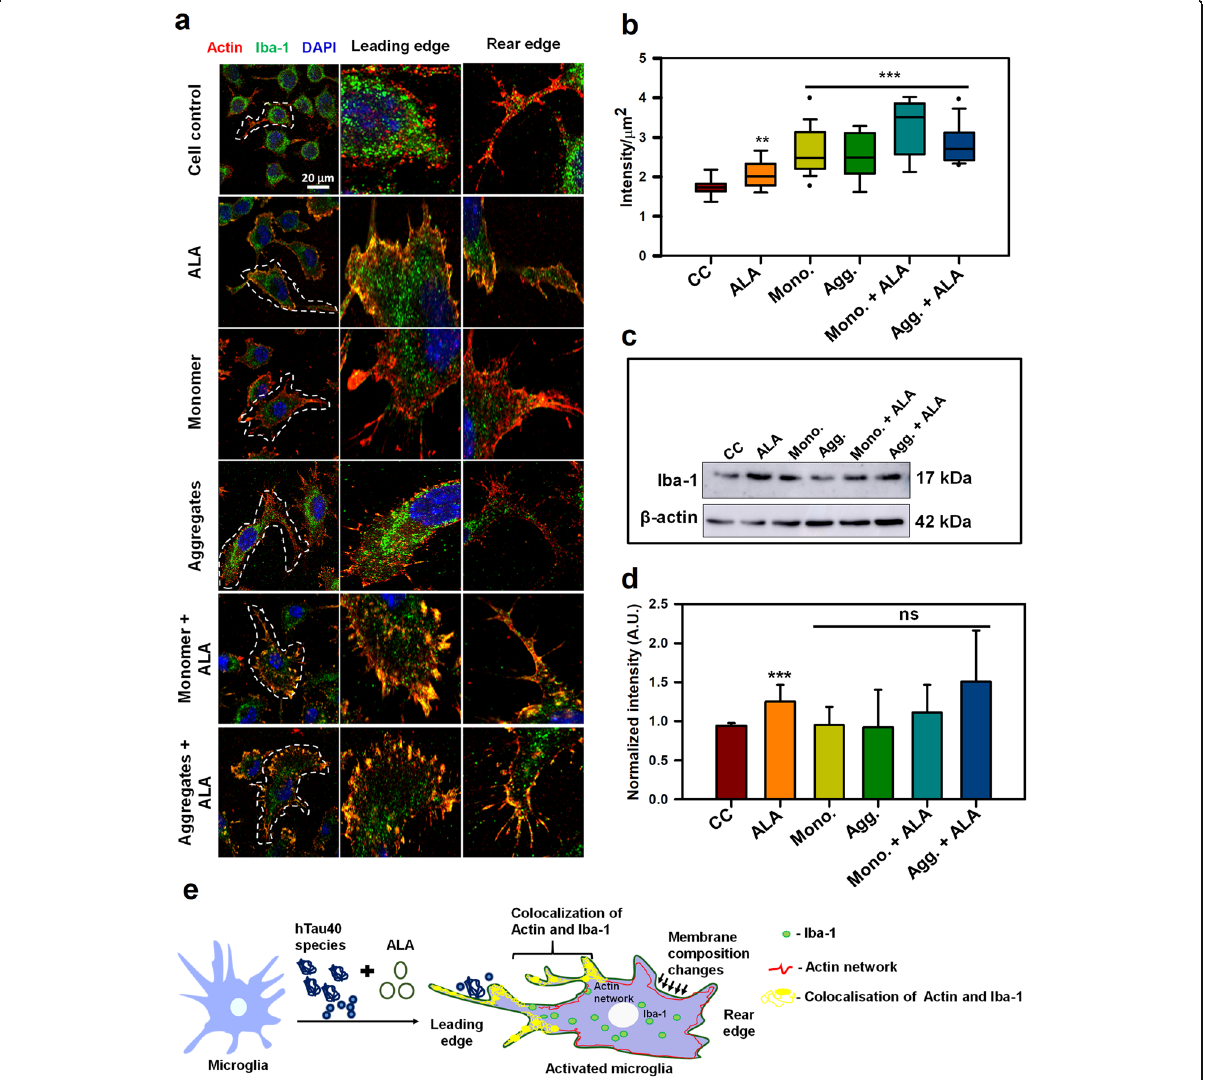
Fig. 3 Modulation of actin network in activated microglia by ALA. Role of actin and Iba-1 in microglial migration and activation a N9 microglial cells were treated with Tau monomer, aggregates along with ALA for 24 h. After fixation cells were stained with β -actin (red) and anti-Iba-1 antibody (green). Colocalization of actin and Iba-1 was studied by Super-resolution confocal microscopy. The single cells are marked with white dotted lines in the merged image, scale bar is 20 μ m. The migratory microglia are shown with the front; leading edge and rear edge and the colocalization of actin and Iba-1 in the edges assisting the microglia for membrane ruffling and phagocytosis. b The quantification of Iba-1 in cell indicating its activation status and its levels on increased phagocytosis. The increased levels of total intensity per μ m 2 area of microglia was calculated with ZEN 2.3 software, significance is ( p < 0.001). c The protein expression of Iba-1 was measured by western blot analysis in all the treated groups after 24 h of treatment and stained with anti-Iba-1 and β -actin antibody for loading control. d Quantification of the intensity of protein bands from western blot normalized with the β -actin loading control. The conditions of Tau monomer and aggregtes with ALA are nonsignificant, ( p > 0.05). e Schematic overview of actin remodeling at leading edge of microglia and involvement of Iba-1 in the process of phagocytosis after ALA treatment to cells. The significance was analyzed with Tukey ’ s Kramer, significant when mean difference between treatment groups (X-X ’ ) > T (Tukey ’ s criteria). The annotations used in graph are as follows- CC (Cell control), ALA ( α -linolenic acid), Mono. (monomer), Agg. (aggregates), Mono. + ALA (monomer plus ALA), Agg. + ALA (aggregates plus